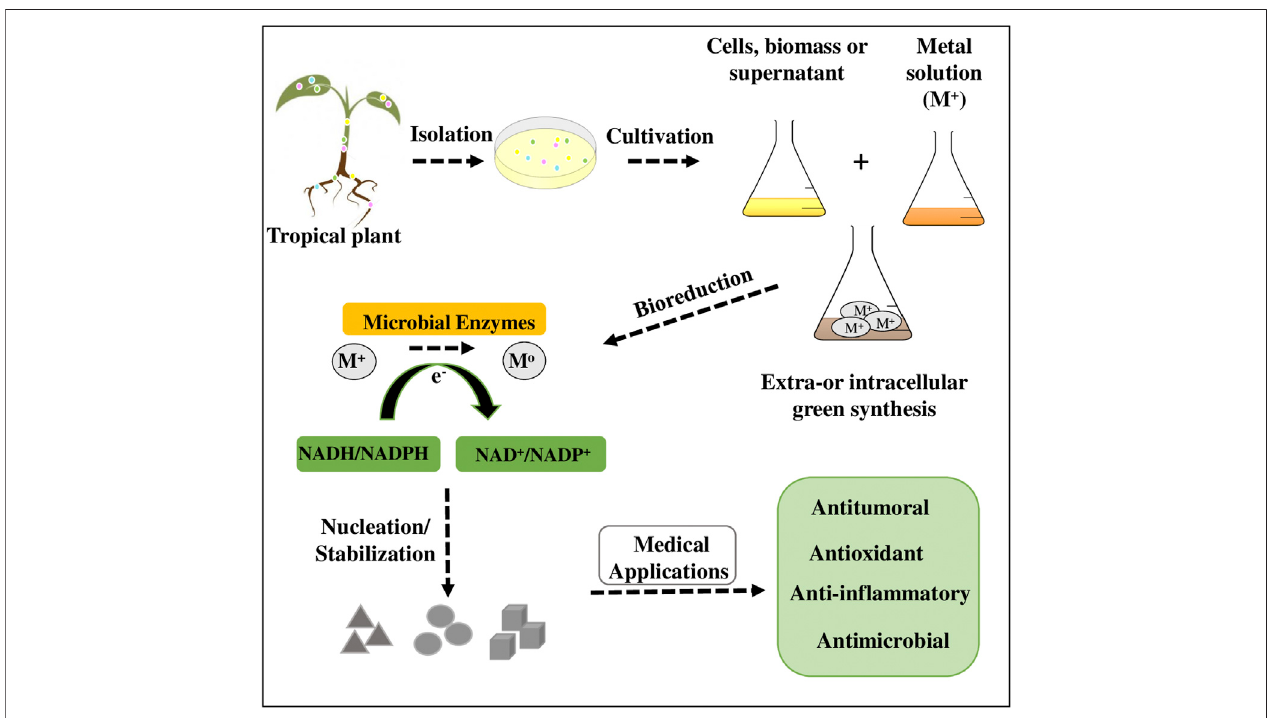
FIGURE 1 | Schematic representation of the general steps for green synthesis of metal-based NPs using endophytic microorganisms isolated from tropical plant.